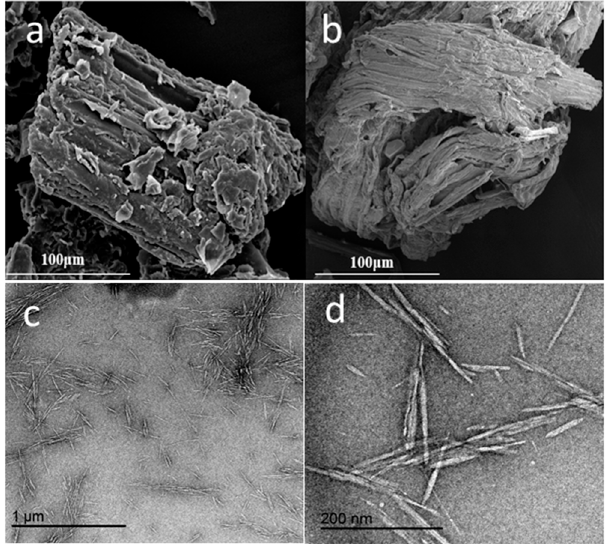
Figure 1. SEM micrographs of ( a ) the raw material and ( b ) the extracted cellulose; ( c , d ) transmission electron microscopy (TEM) micrographs of the cellulose nanocrystals (CNCs) isolated from the corn stalk.